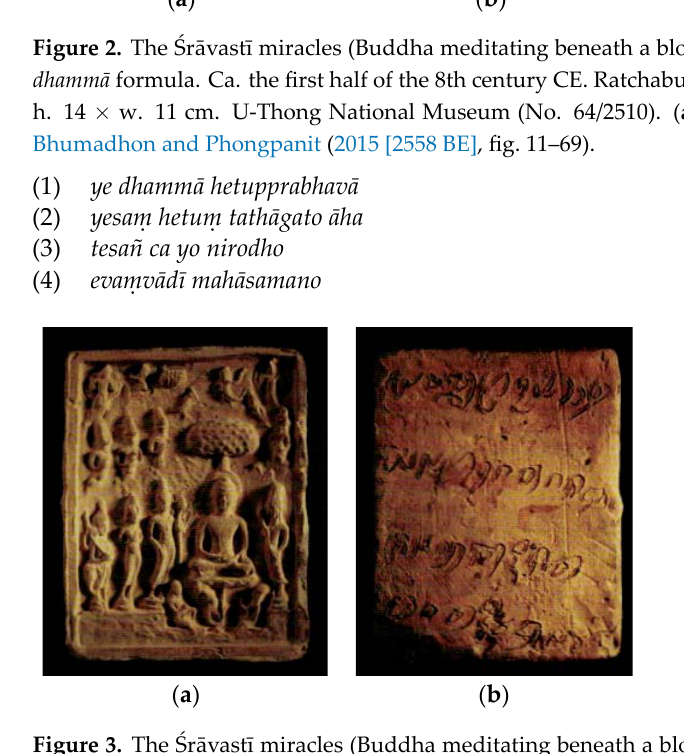
( b ) Figure 4. The Ś r ā vast ī miracles (Buddha meditating beneath a blooming tree and the n ā ga ) with ye dhamm ā formula. Ca. 7th ‐ 9th centuries CE. Moulded tablet, clay. Songkhla National Museum. ( a ) Font Side; ( b ) back Side. After Revire (2014, fig. 15a,b). These three examples all belong to the yesa ṃ group. The language used in a number of these inscriptions is not orthographically correct, reflecting the fact that the common tongue was extremely fluid and diverse (Saraya 1999, p. 196). They have in common cer ‐ tain spelling peculiarities in which mah ā samano is spelt with a dental n rather than the standard retroflex ṇ and ti is omitted; these are common to other occurrences of ye dhamm ā inscriptions belonging to this group and cannot, therefore, be simply deemed as a scribal error (Revire 2014, p. 259). The inscription of ye dhamm ā verse found in Nakhon Pathom follows the canonical group ( tesa ṃ ), while the inscriptions from the yesa ṃ group appear in Ratchaburi province, central Thailand, and are far more numerous and widespread.